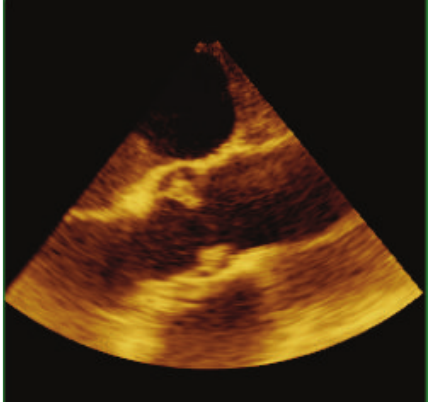
Figure3:2Dmidesophagealaorticvalvelongaxiswithnotablelarge